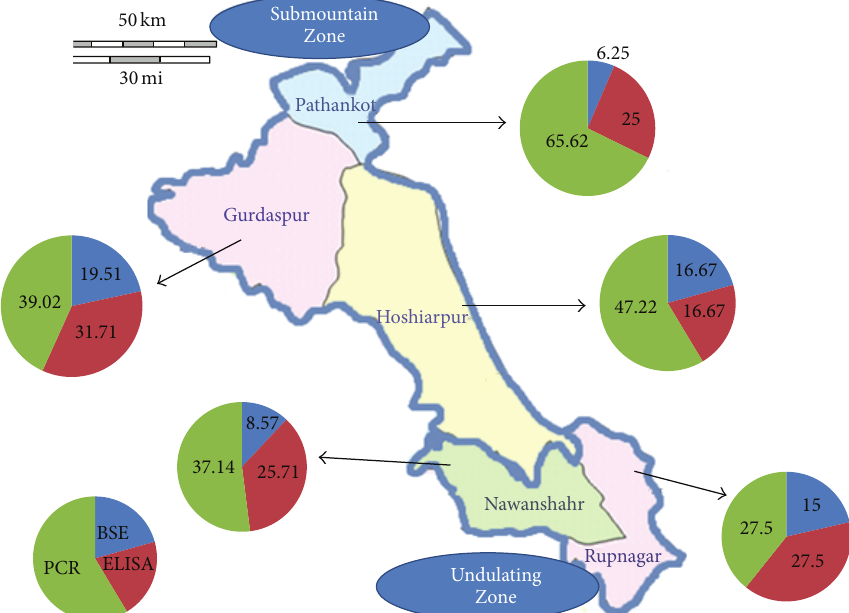
Figure 1: Map of Submountain and Undulatng Zone of Punjab indicating the incidence of A . marginale among different districts under study as diagnosed by Blood Smear Examination (BSE), Enzyme Linked Immunosorbent Assay (ELISA), and Polymerase Chain Reaction (PCR).